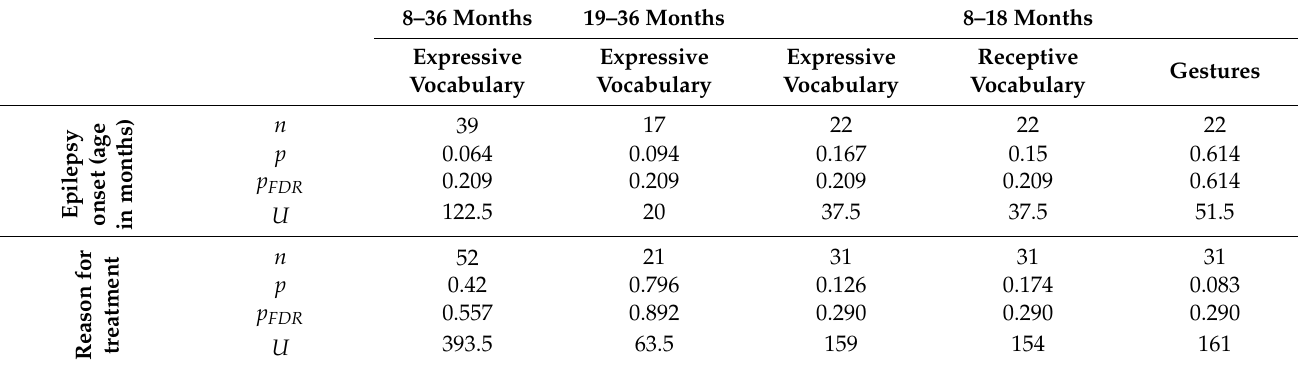
Table 2. The comparison of results of the SDCI questionnaire according to age of seizure onset, the reason for antiepileptic treatment introduction, duration of the seizure presence, number of currently taken antiepileptic drugs, and observed response to present treatment (i.e., decrease in seizure, seizure remission, or no